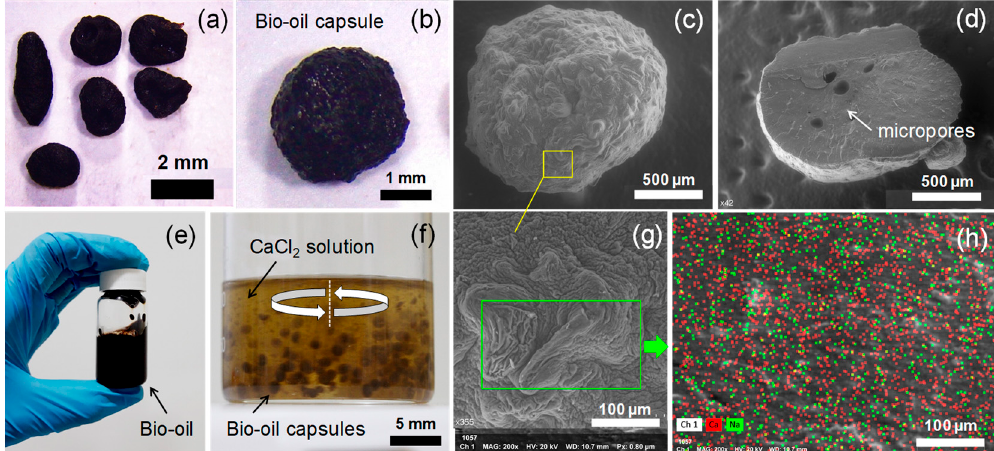
Figure 4. ( a ) Image of the different BO capsules produced as result of the alginate concentration and encapsulation method used; ( b ) individual spherical BO capsule; ( c ) SEM image of BO capsule; ( d ) SEM image of the cross-section of BO capsule; ( e ) liquid Bio-Oil (BO) obtained from liquefied agricultural biomass waste; ( f ) BO capsules in hardening bath of calcium chloride; ( g ) SEM detail image of surface structure on BO capsule; ( h ) SEM-EDS on the BO capsule surface.